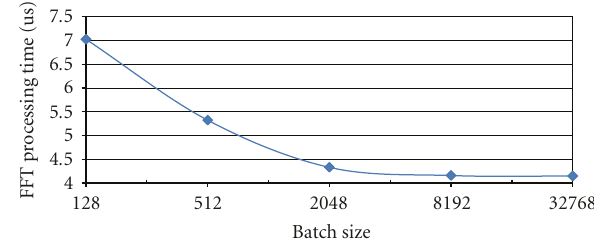
Figure 5: Graph showing the calculation time per FFT against batch